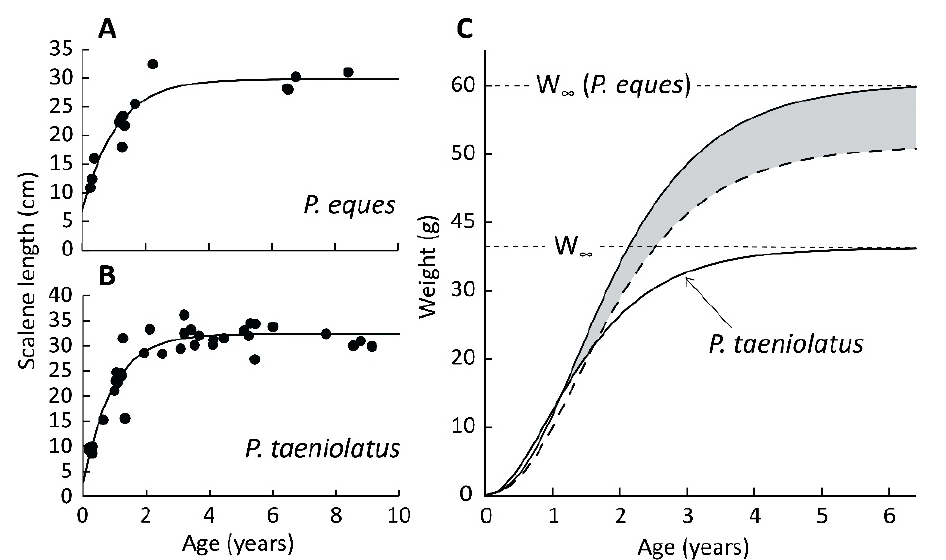
Figure 4. Von Bertalanffy growth curves in (‘scalene’) length of common ( A ) and leafy ( B ) seadragon of both sexes (see also Table 4), and weight growth curves for both species ( C ). Note the contribution of the appendages and their supporting spines to the weight of the leafy seadragon (grey area and Table 5).